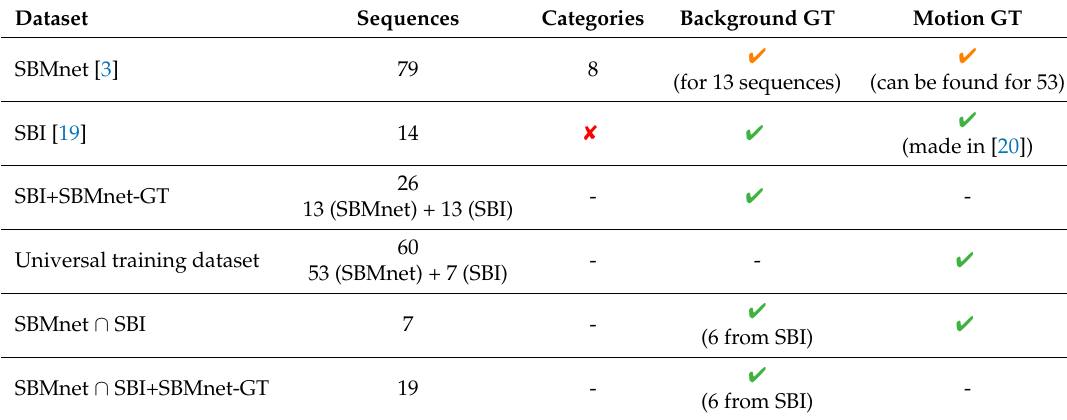
Table 1. Main characteristics of the datasets considered in our experimental setup. For each dataset (1st column), we provide the number of sequences (2nd column) and categories (3rd column) and the availability of ground-truth background images (4th column) and motion ground-truths (5th column). The symbol “-” indicates that the given information is not relevant for our